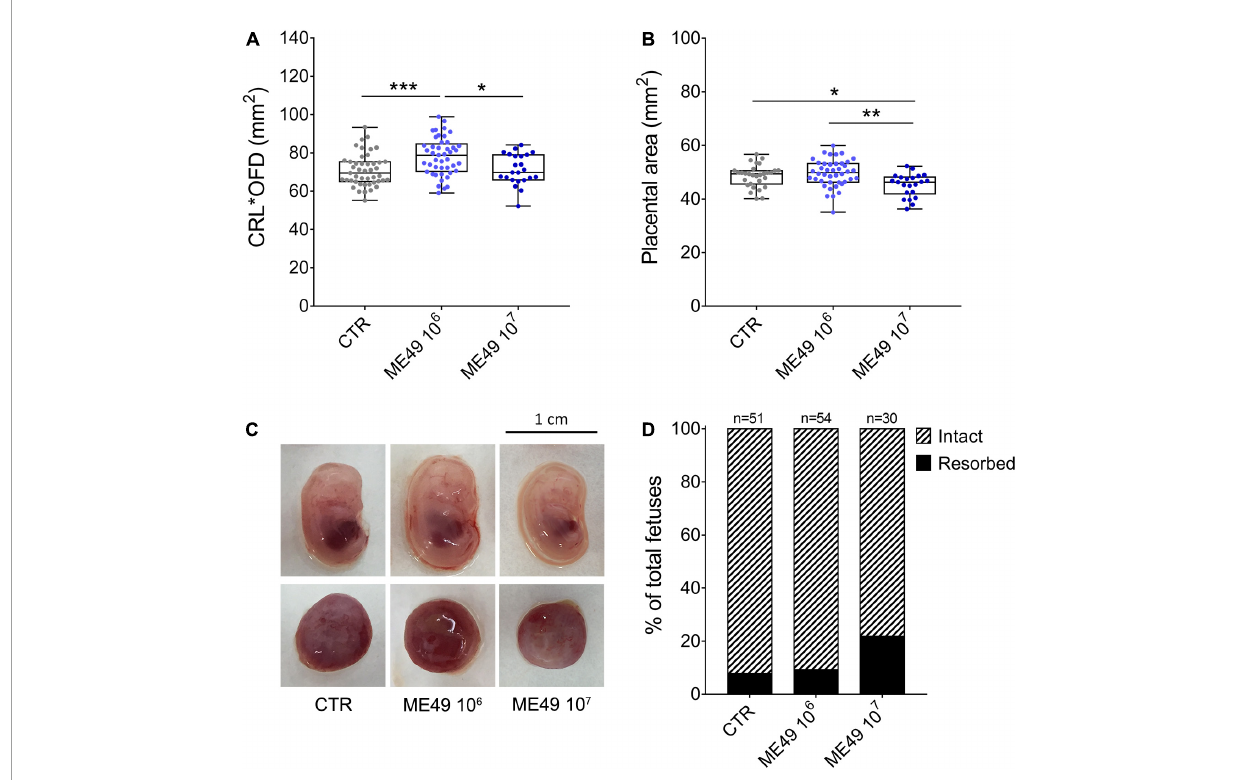
FIGURE3 Impact of infection on fetal and placental size and fetal resorption rates during maternal-fetal transmission of T. gondii in Swiss Webster mice. Pregnant dams were infected with 10 6 or 10 7 tachyzoites (ME49 strain) at E8.5 or E9.5 and euthanized at E13.5 or E14.5. (A) Fetal size was calculated by multiplying the crown-to-rump length (CRL) by the occipital-frontal diameter (OFD) and expressed as mm 2 ; n = 23–45 samples from at least two independent pregnant dams for each condition. (B) Placental area was measured and expressed as mm 2 ; n = 22–42 samples from at least two independent pregnant dams for each condition. Each symbol represents data from individual fetuses (A) or placentas (B) . Data are presented as median ± interquartile range. One-way ANOVA with Tukey’s multiple comparisons test was employed. * p < 0.05; ** p < 0.01; *** p < 0.001. (C) Representative images of fetuses and placentas for each condition. (D) Resorption rates of uninfected (CTR) or T. gondii -infected (ME49 10 6 and ME49 10 7 ) pregnant dams; n = 30–54 samples from at least two independent pregnant dams for each